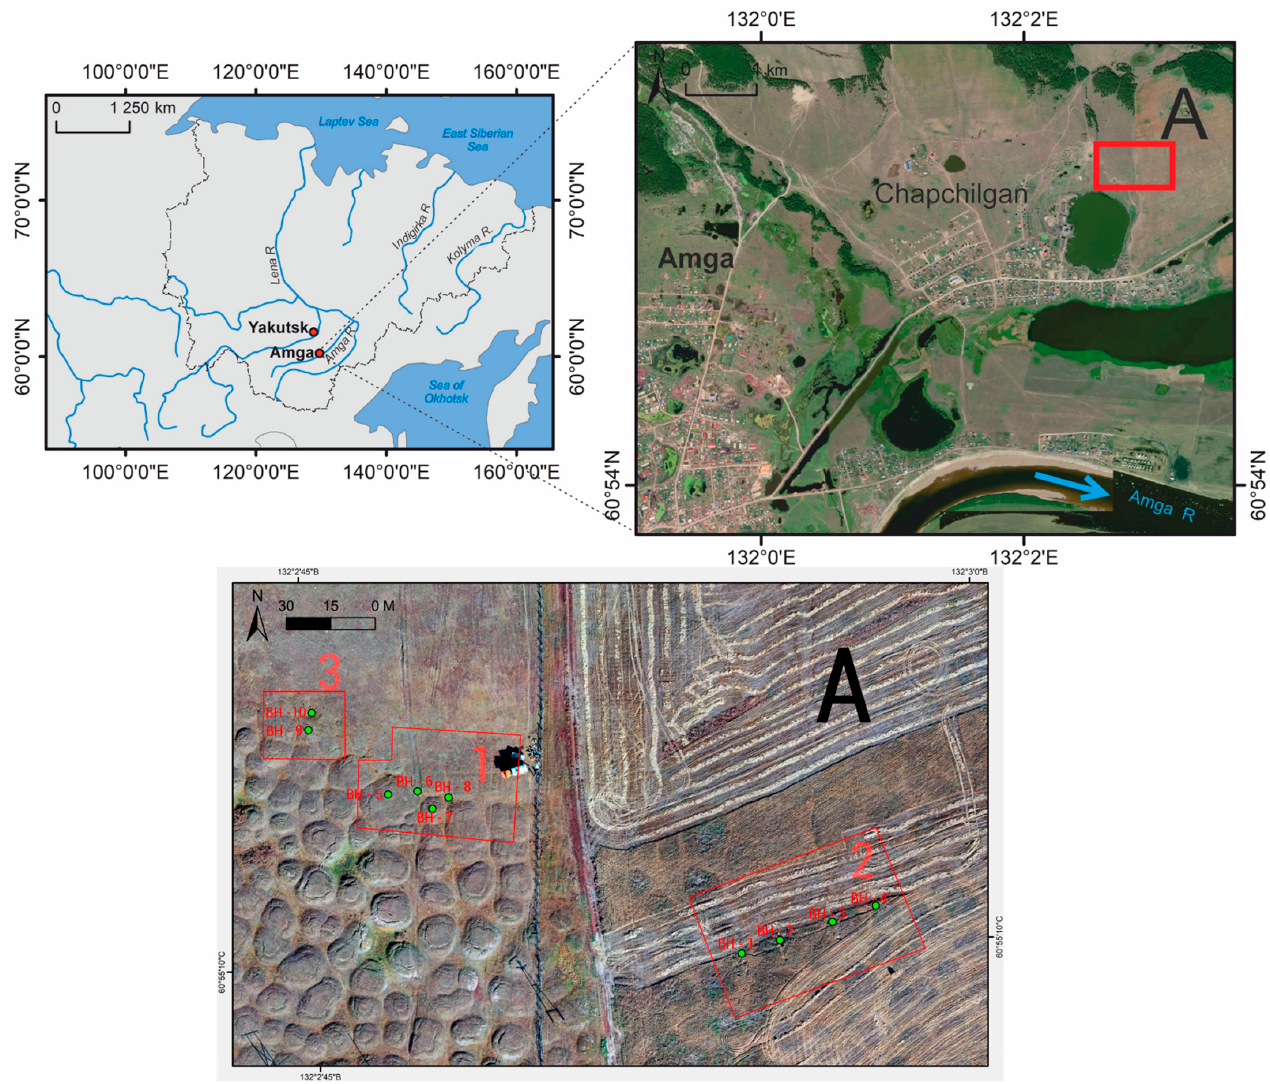
Figure 1. Location of the study area. 1—experimental area № 1, 2—experimental area № , and 3—control area.